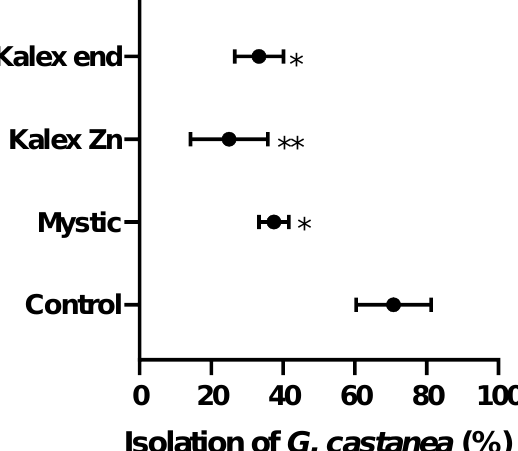
Figure 1. Percent of isolation of Gnomoniopsis castaneae from chestnut fruits of trees in the four treatments of 2019. Bars represent the SEM. Statistical differences with the untreated control at the Dunnett’s Multiple comparison tests are evidenced by * = p < 0.05, and ** = p < 0.01.